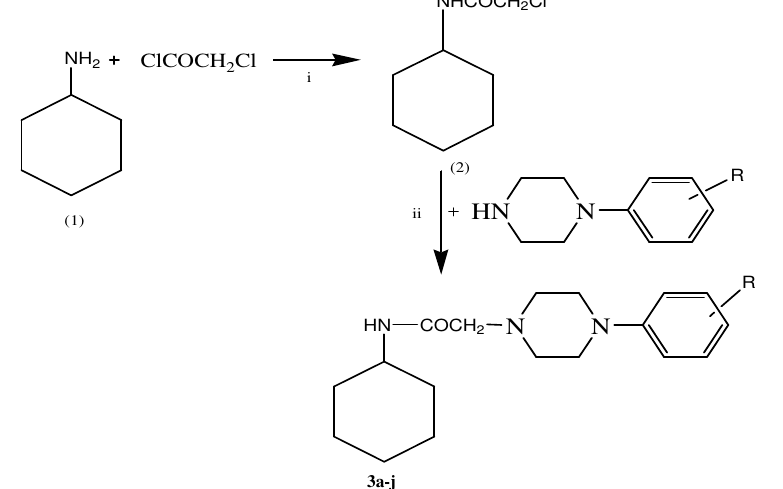
Scheme 1. Synthesis of the target compounds. Reagents and condition : (i) NaOH, dichloromethane (ii) acetonitrile, K